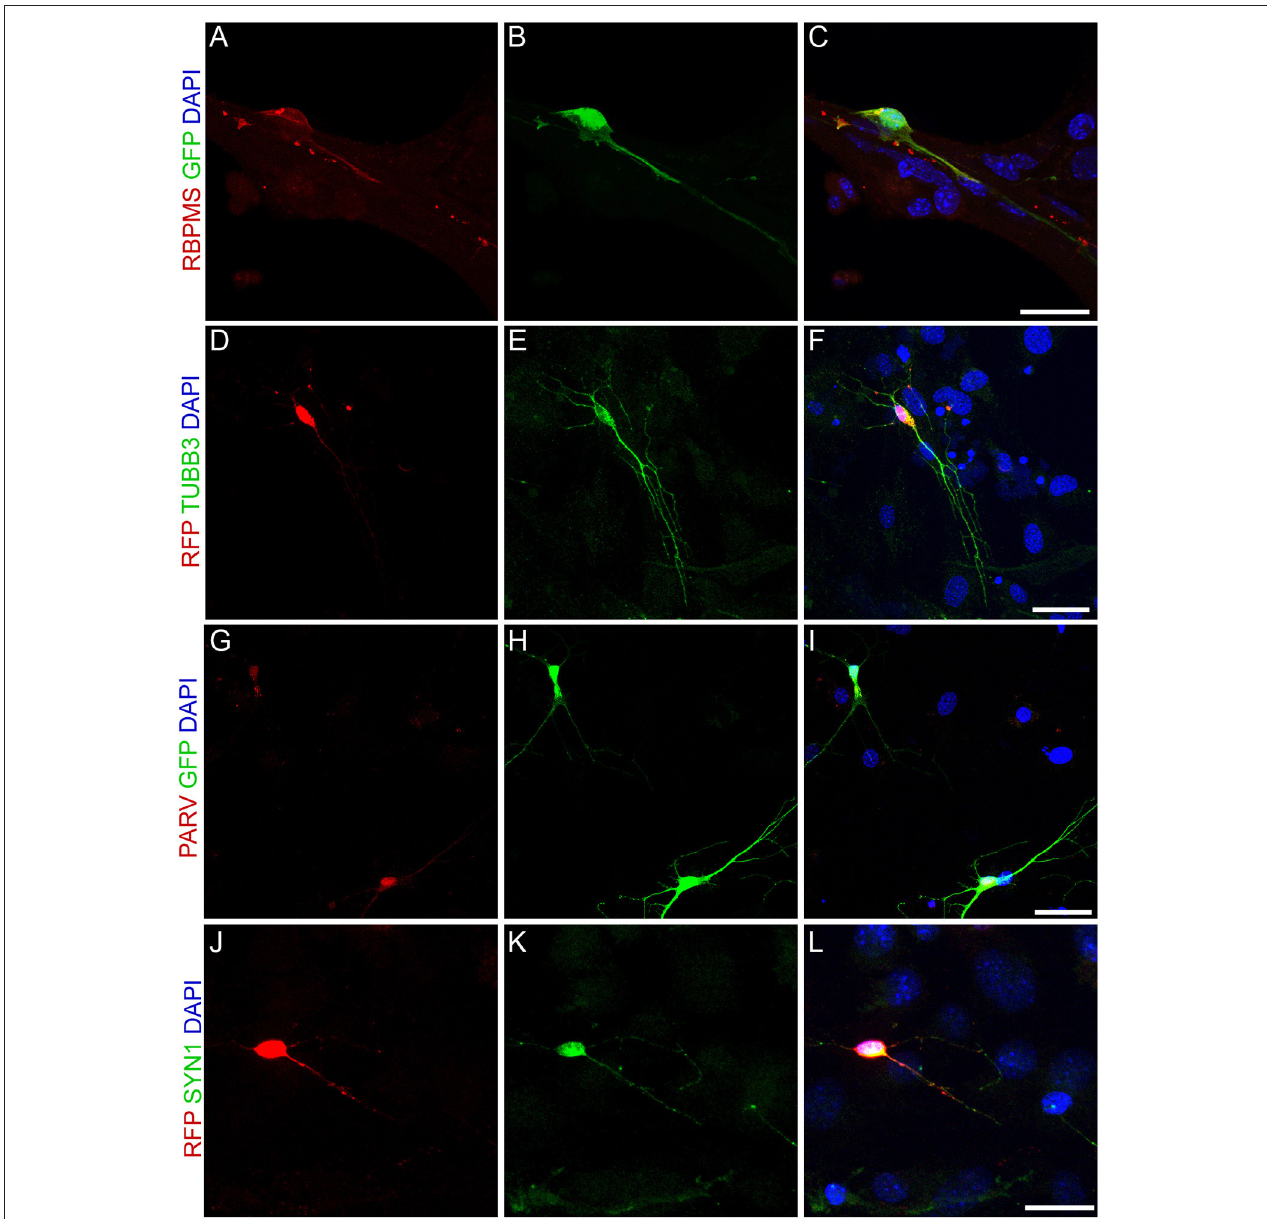
FIGURE 6 | Expression of NEUROG2 induces the acquisition of RGC-like phenotypes in MGC-derived iNs. (A–L) Immunolabeling of the RGC proteins RBPMS (red, A–C ), β III -TUBULIN (green, D–F ), PARV (red, G–I ) and SYN1 (green, J–L ) in MGC converted into iNs at 15 days post-nucleofection with either Neurog2-I-GFP (green, A–C and G–I ) or Neurog2-I-DsRed (red, D-F and J-L ). Scale bars: 20 µ m.